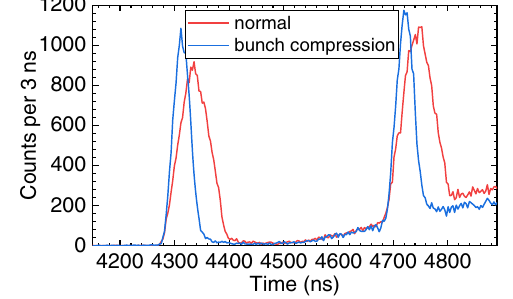
FIG. 7. Proton bunch length by measuring the γ -flash response waveform in the Back-n white neutron beam line: the normal operation mode (red); the target-shooting mode with the bunch compression (blue). It shows that the proton bunch length in this target-shooting mode is approximately half of that in the normal mode.